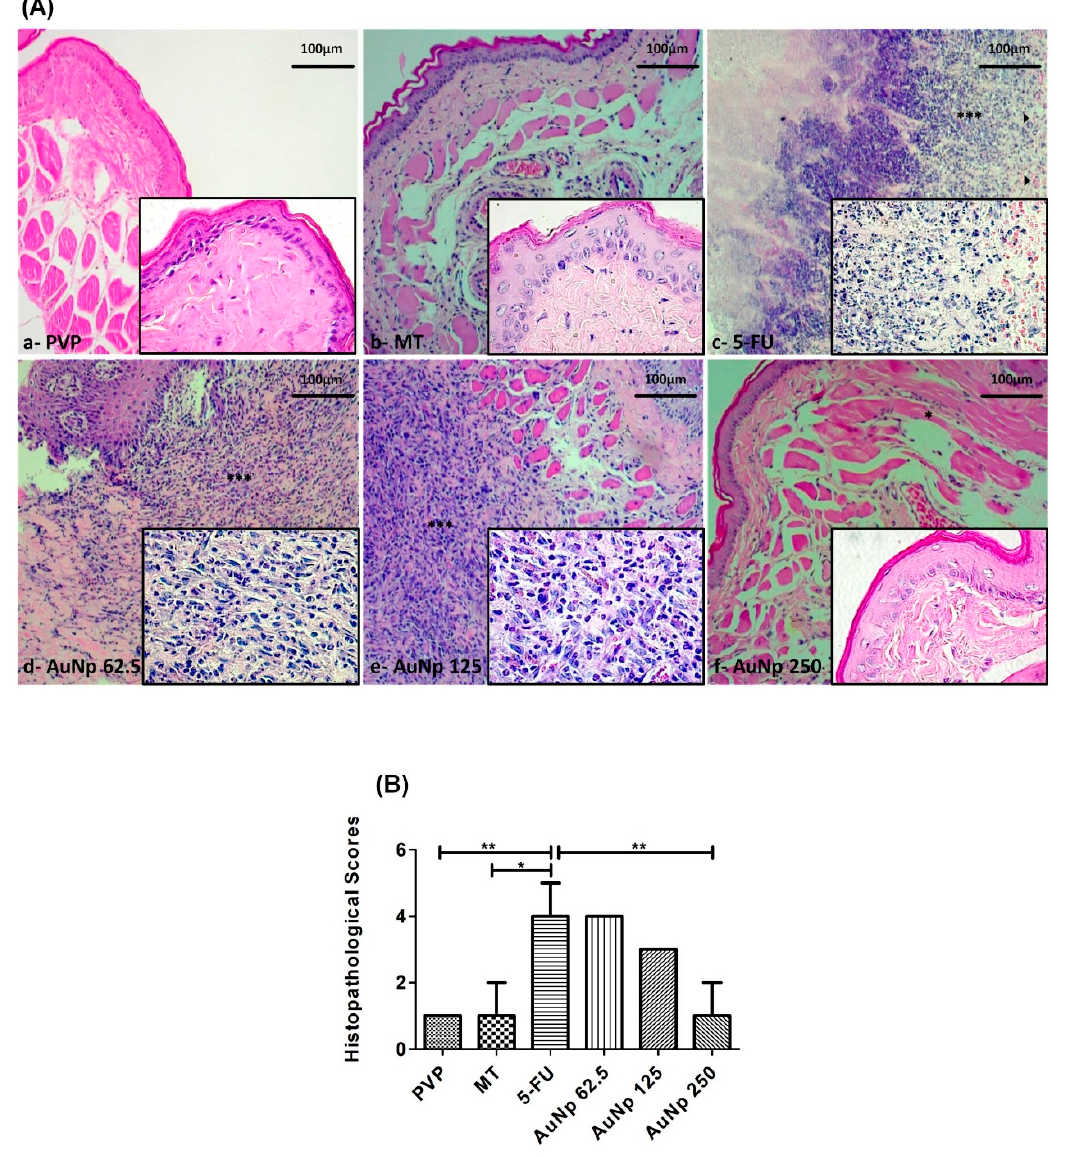
Figure 2. ( A ) Histopathological analysis of oral mucositis in hamsters on the 10th day of the experimental model. PVP group: Animals with normal tissue aspect ( a ). MT group: Animals without oral mucositis. ( b ). Group 5-FU: Animals with OM induced by 5-FU ( c ) and mechanical trauma, the oral mucosa showed areas of epithelial degeneration, hemorrhagic foci ( ► ), intense inflammatory infiltrate (***), and regions suggestive of necrosis. Groups treated with AuNp 62.5 ( d ) or 125 μ g/kg ( e ) did not improve oral mucositis. The group treated with AuNp 250 μ g/kg ( f ) showed re- epithelialization with focal areas of inflammatory infiltration (*). ( B ) Score graph with the standard error of the median ( n = 5/group). * p < 0,05; ** p < 0.001 (Kruskal–Wallis test and Dunn’s multiple comparison test).